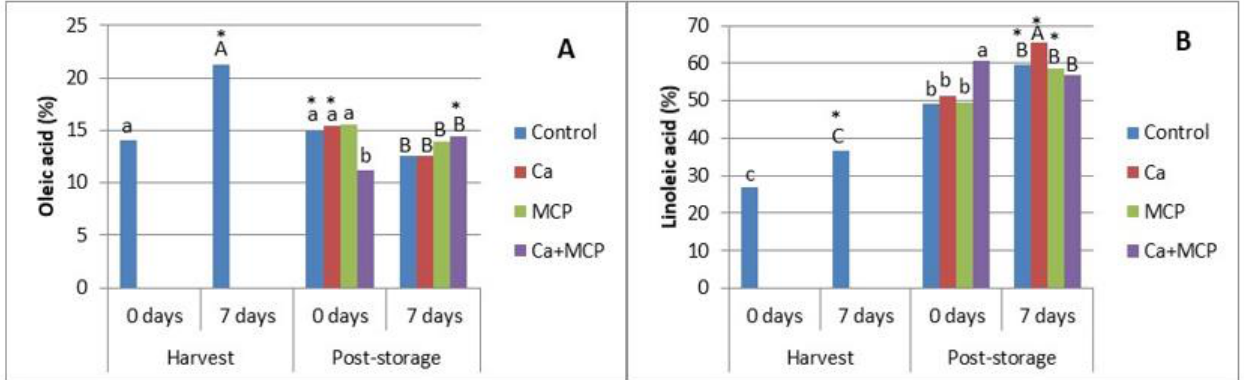
Figure 2. Changes in the unsaturated fatty acids, oleic ( A ) and linoleic ( B ), at harvest and after 6 months of storage at 0.5 ◦ C and their respective shelf-life (7 days at ≈ 22 ◦ C), in ‘Golden Delicious’ apples subjected to postharvest treatments with calcium chloride (Ca), 1-MCP (MCP), calcium chloride plus 1-MCP (Ca + MCP) and control. Lower-case letters compare treatments at harvest and after 6 months, and upper-cases letters compare treatments after shelf-life. Columns with the same lower- or upper-case letters are not significantly different as determined by Duncan’s multiple range test at p < 0.05. * represents significant differences between harvest and shelf-life or between poststorage and shelf-life for each treatment, at p < 0.05.